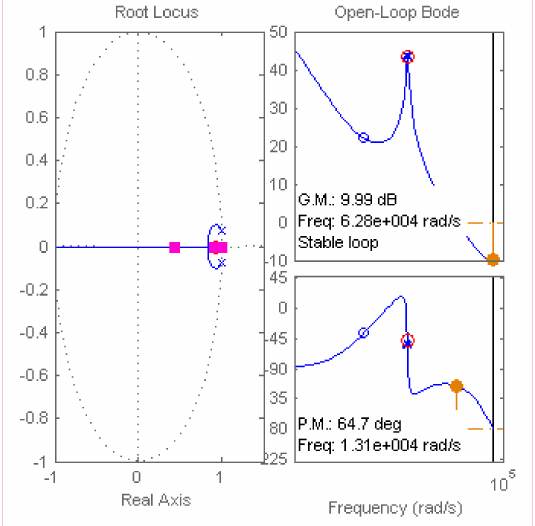
Figure 9. Behavior characterization of the control loop with the PI controller designed in Matlab.